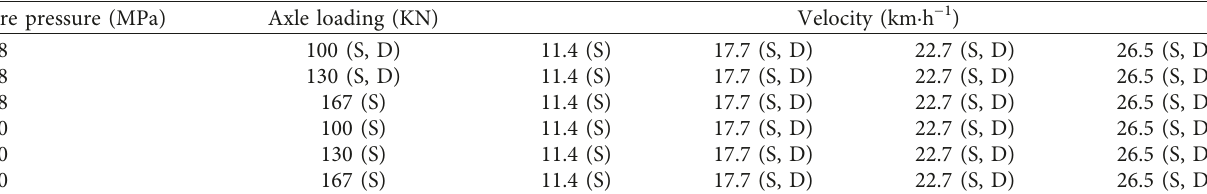
Table 6: APT loading (S represents single axle, and D represents dual